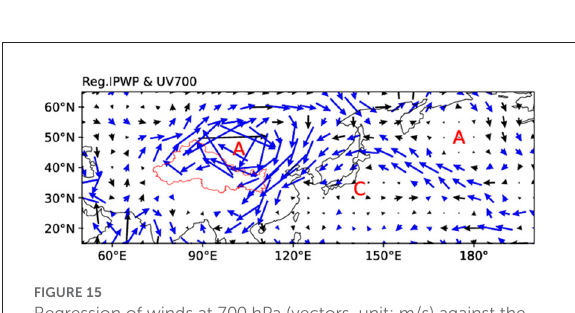
FIGURE15 Regression of winds at 700 hPa (vectors, unit: m/s) against the Indian Ocean SST anomaly index. A and C denote the centers of anomalous anticyclones and cyclones, respectively. Blue arrows denote significance at the 95% confidence level (Wu et al.,